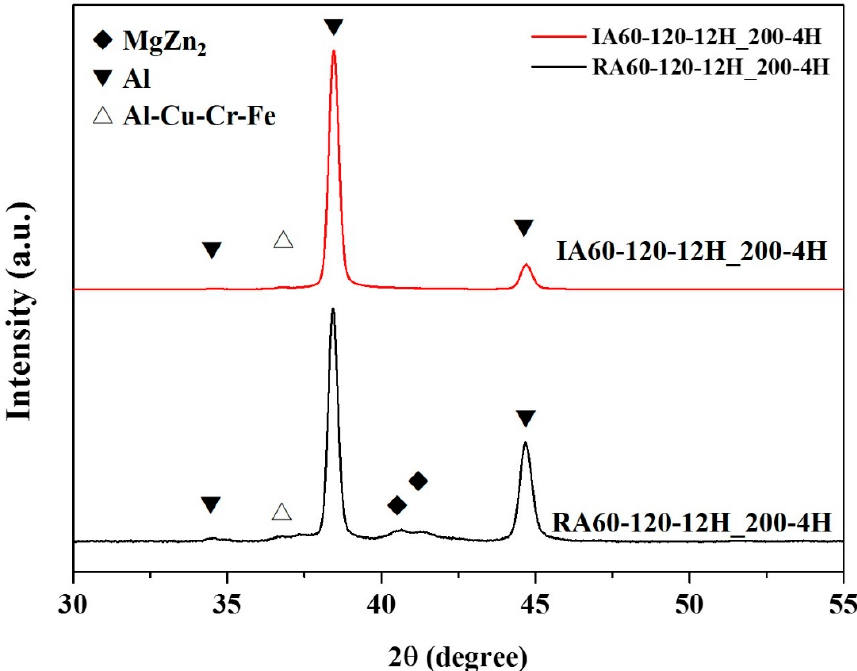
Figure 13. XRD patterns of specimens after the high-temperature test (200 °C, 4 h).